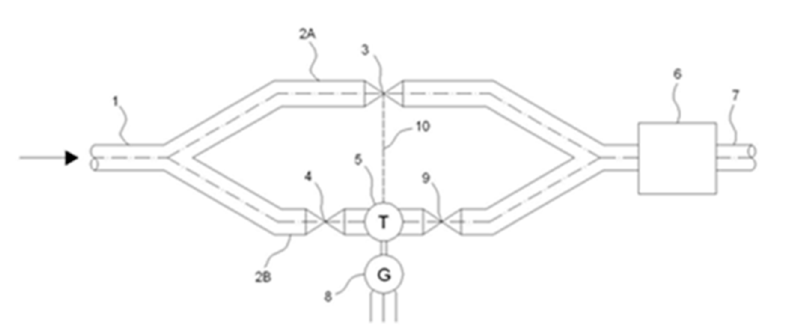
Figure 2. Device